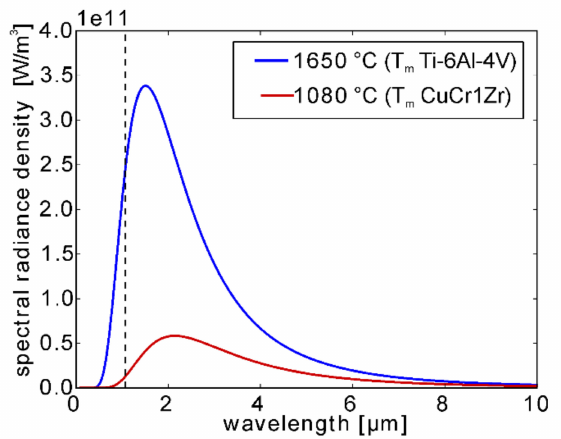
Figure 1. Spectral radiance of an ideal black body according to Planck’s law for two di ff erent temperatures corresponding to the melting temperatures of CuCr1Zr and Ti-6Al-4V. For reference, the wavelength of the laser is marked by a black dotted line. Significantly lower MPM intensities can be expected for CuCr1Zr due to the lower melting point in the black body